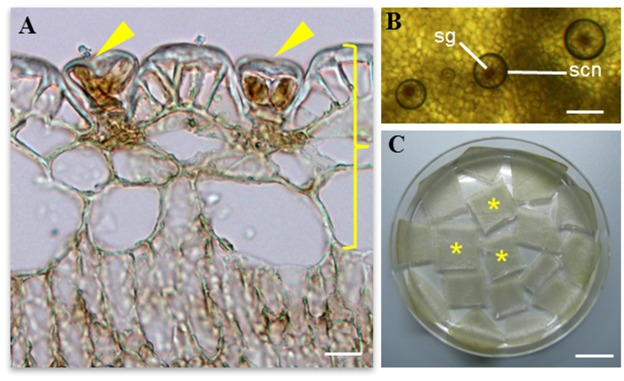
Salt glands of the mangrove species Avicennia officinalis.(A) Transverse section of leaf showing the adaxial (upper) epidermal layer with two salt glands (arrows). (B) Secretion (scn) above the salt gland (sg) can be observed from the top view of the adaxial epidermal layer. (C) The salt gland-enriched epidermal peels (*) as indicated by the right brace in (A) were obtained from the leaves for subsequent protein extraction and downstream proteomic analysis. Scale bars: 20μm (A), 100μm (B), 1cm (C).